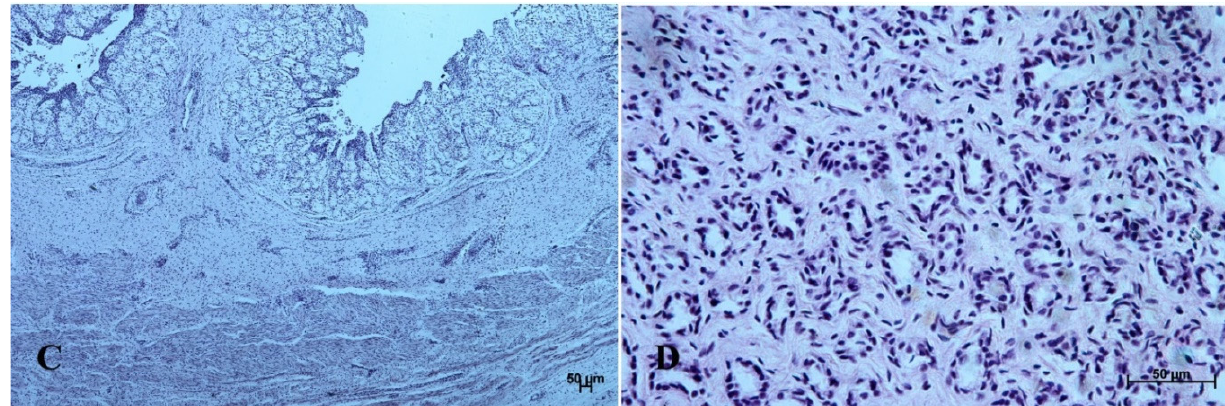
Figure 4. Histological structure of stomach mucosa in the cardiac part (hematoxylin-eosin staining). ( A )—the first age group (10×); ( B )—the second age group (20×); ( C )—the third group (5×); ( D )—the reference adult group (40×).